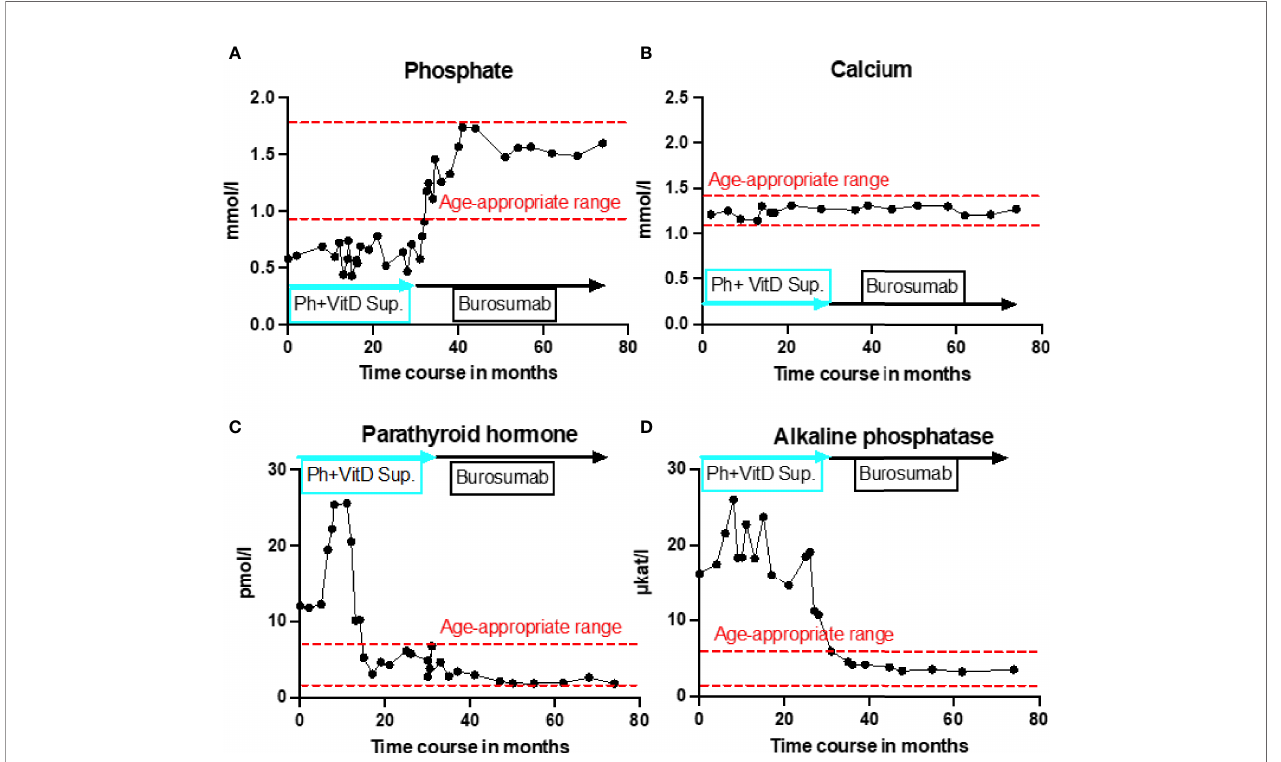
FIGURE 2 | Timeline representation of laboratory values over 42 months of burosumab treatment. All graphs show individual laboratory values over the entire treatment course, starting from initial presentation at the age of 3.5 years until recently. Red dashed lines indicate age-appropriate norm range. Blue rectangle indicates conventional treatment with calcitriol and phosphate supplementation. Black rectangle indicates treatment with burosumab. (A) Serum phosphate levels in mmol/L showed no change under conventional treatment but rapidly normalized under burosumab treatment and remained in age-appropriate range throughout the entire follow up. (B) Calcium parameters in mmol/l constantly remained in the age-appropriate rage regardless of the treatment type. (C) Parathyroid hormone in pmol/l was severely increased under the fi rst 12 months of conventional treatment and without treatment change decreased to the upper limit of age-appropriatre norm range. Under burosumab treatment further slight decline to lower end of age-appropriate range. (D) Alkaline phosphatase in m kat/l remained strongly increased under conventional treatment and showed a rapid normalization to the age-appropriate range under burosumab